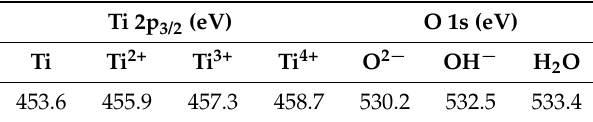
Table 1. Energies of XPS-peaks of